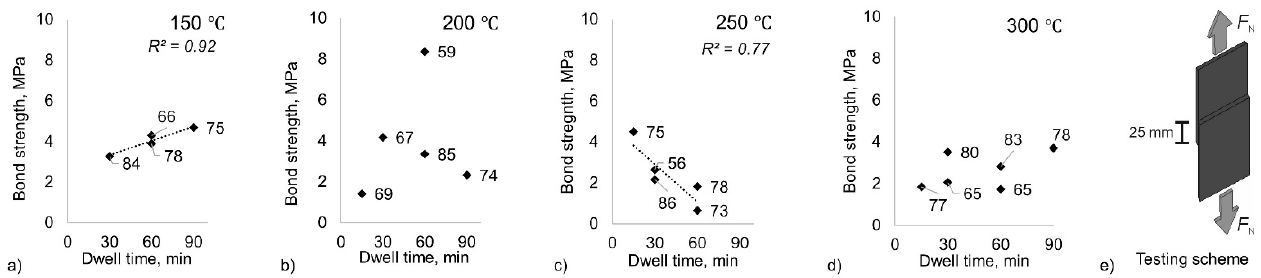
Figure 3. Bond strength as a function of dwell time at 150 °C ( a ), 200 °C ( b ) [23], 250 °C ( c ) [23], and 300 °C ( d ), with the corresponding reduction ratios of the specimens given in % as is represented as the datapoint label and the employed testing scheme ( e ).